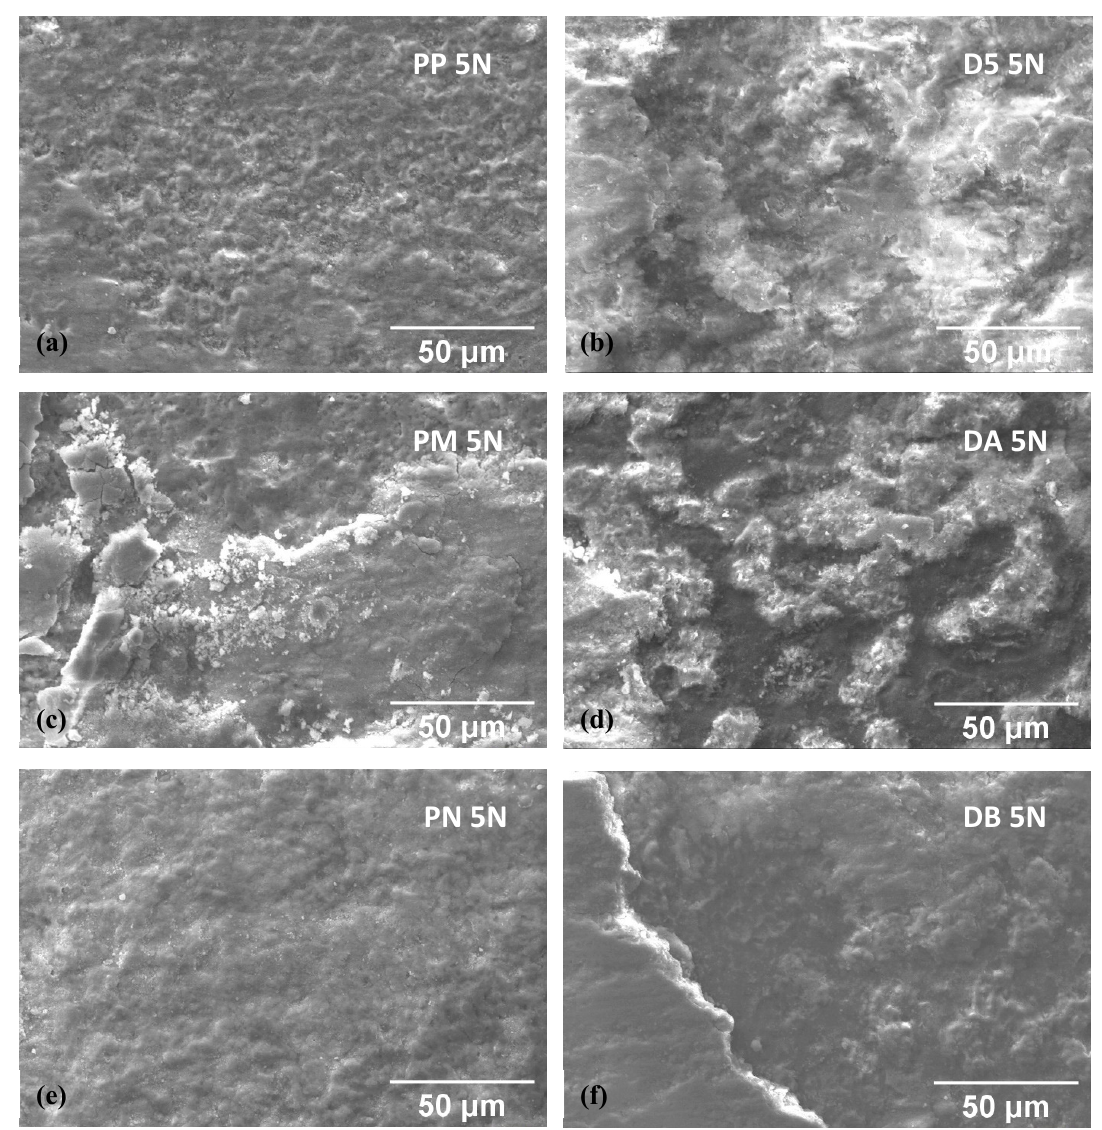
Figure 10. SEM images of wear scars at 5 N on single layers (PP: a , PM: c , PN: e ) and double layers (D5: b , DA: d , DB: f ) showing the presence of iron oxide based transfer layers with variable degrees of coverage and stability. Under 5 N, layers PM and DB are already at the load before coating failure and the transfer layer starts to detach.